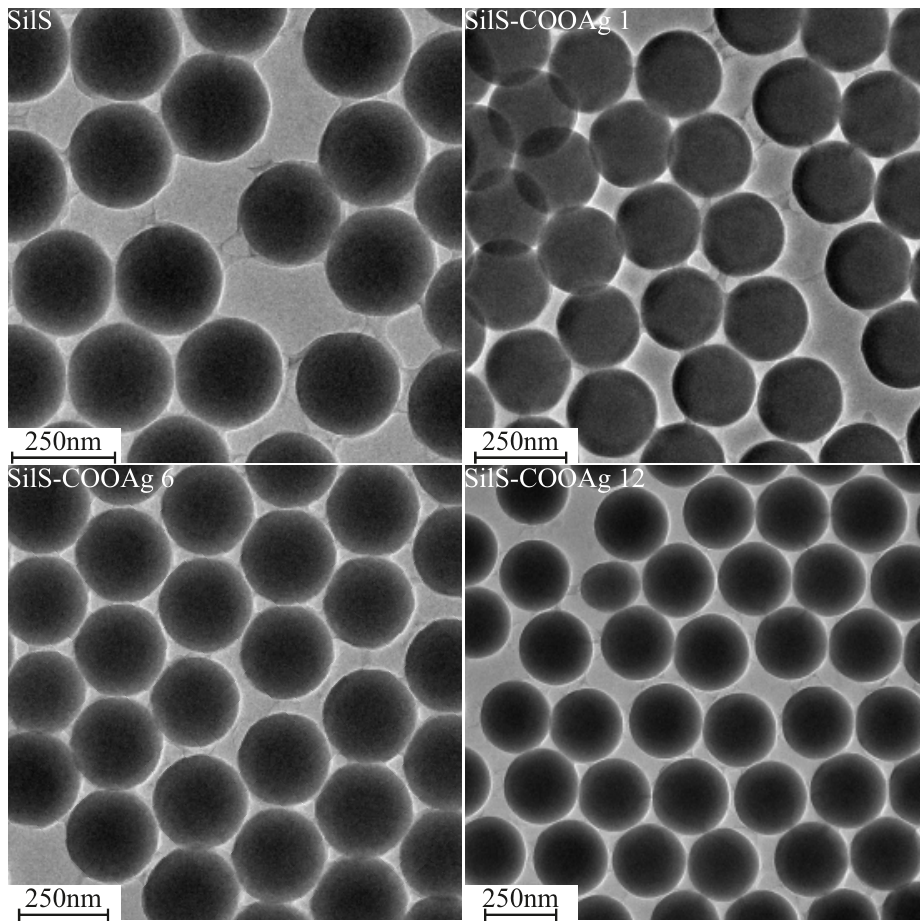
Figure 2. TEM images of functionalized samples (SilS-COOAg 1, SilS-COOAg 6, and SilS-COAg 12) and reference—pure spherical silica